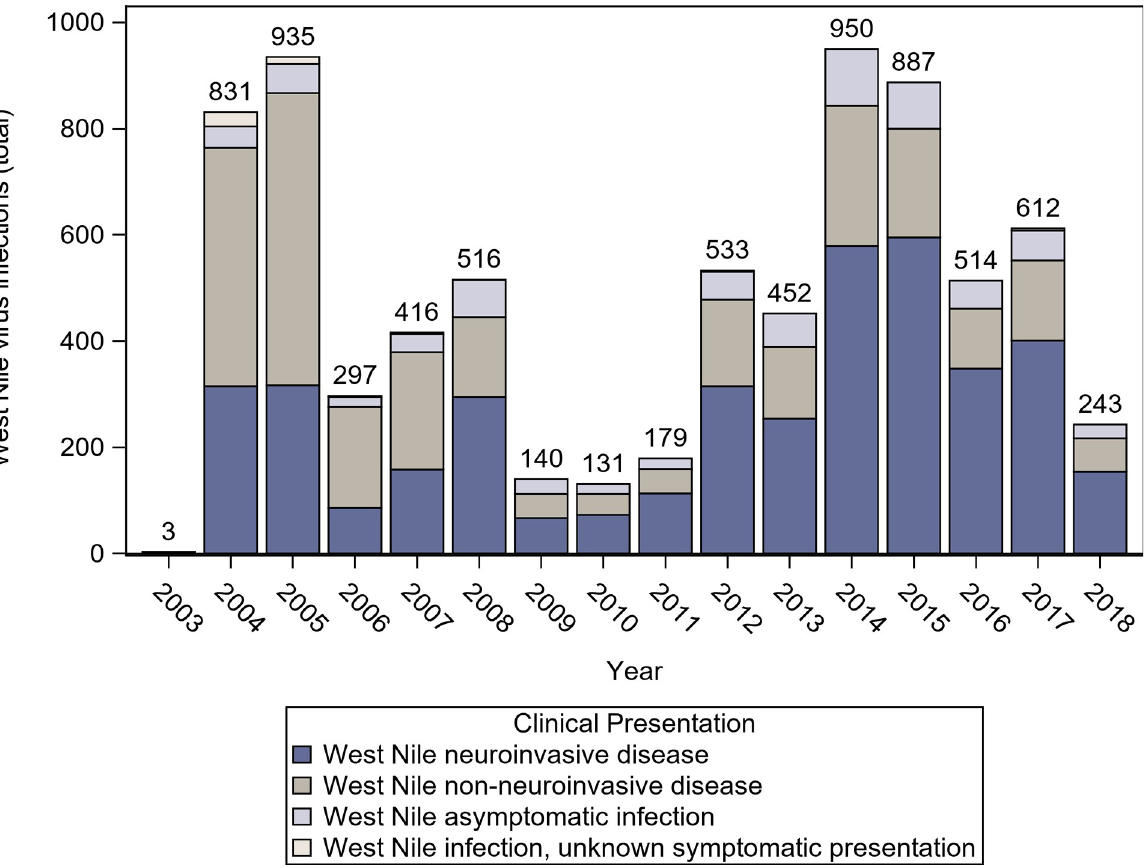
Fig 1. Human West Nile virus infections reported to California Department of Public Health, by clinical presentation, by year, California, 2003–2018.